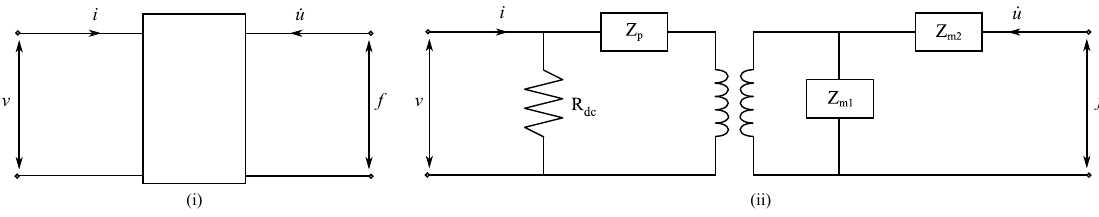
Figure 5. IPMC grey-box models: (i) two-port model concept [85,86], and (ii) transformer circuit model